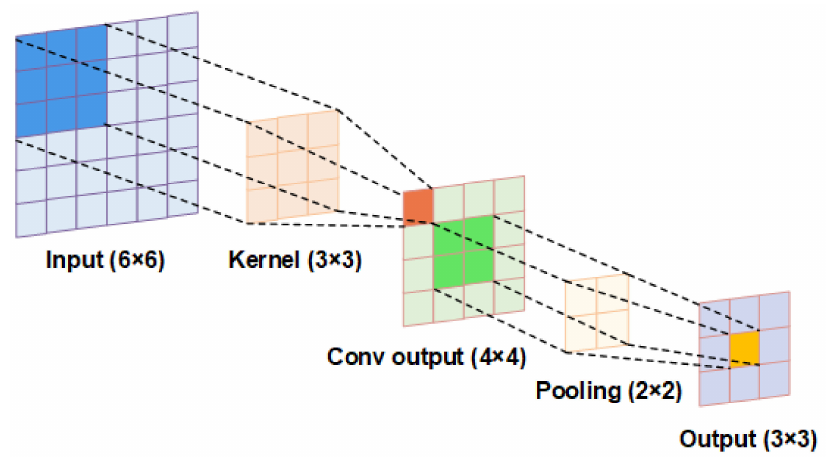
Figure 1. The structure of the convolutional neural